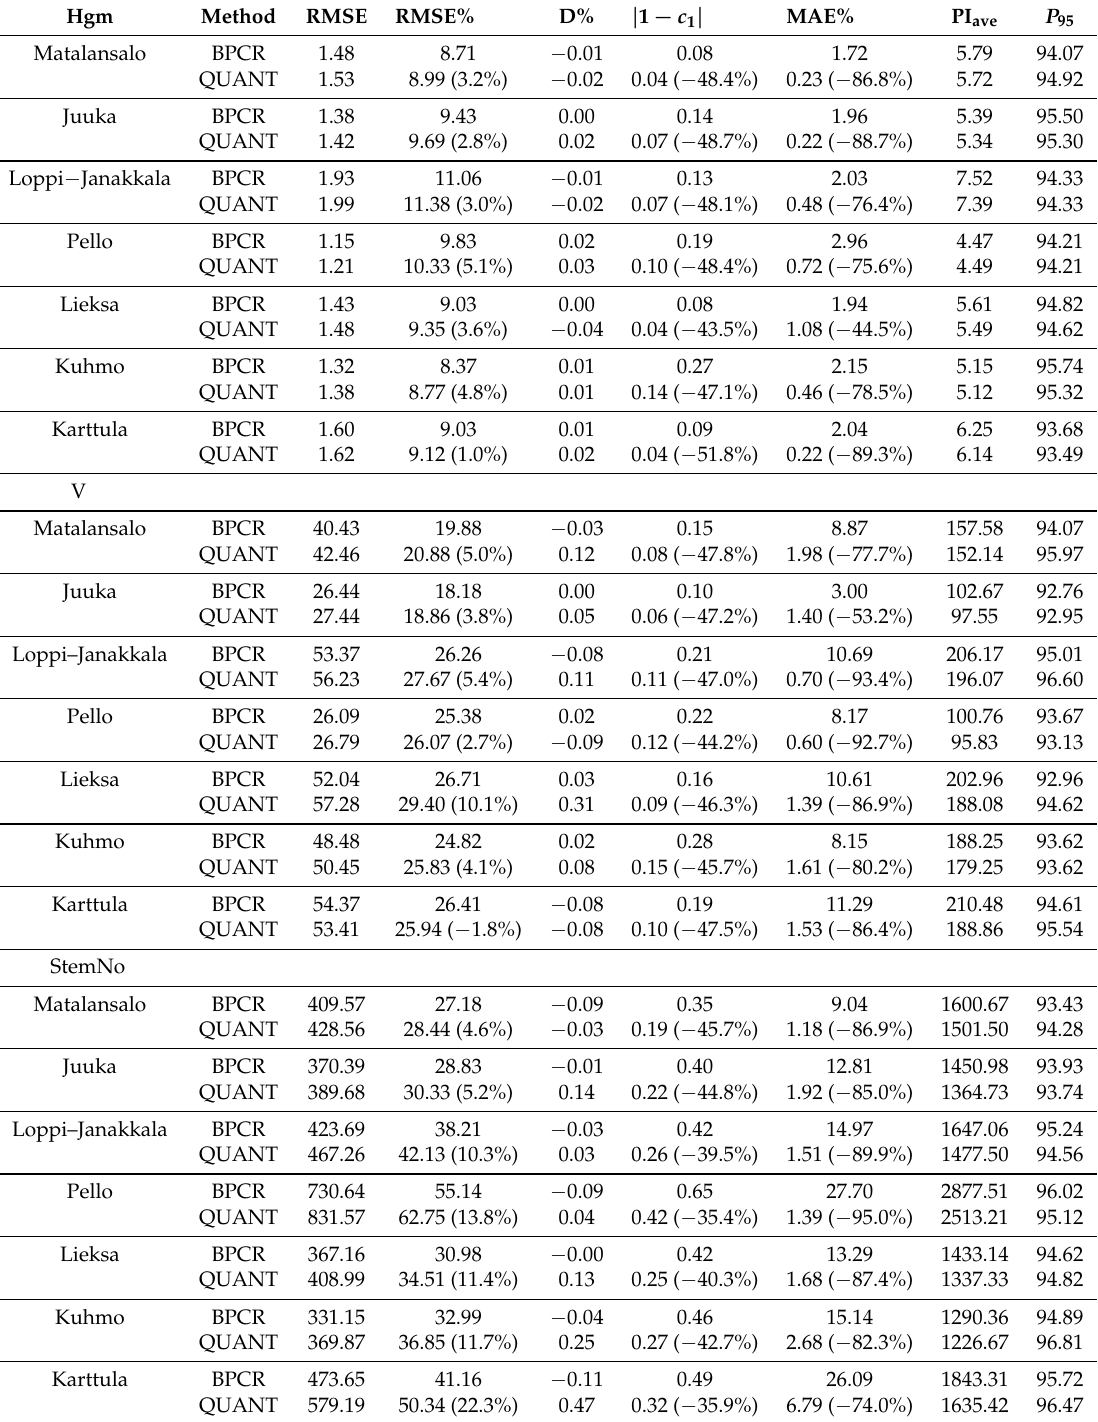
Table 1. Plot level LOPO results for all the study sites and forest attributes. The relative changes in the RMSE%, slope error | 1 − c 1 | and MAE% after the post-processing with QUANT method are shown in